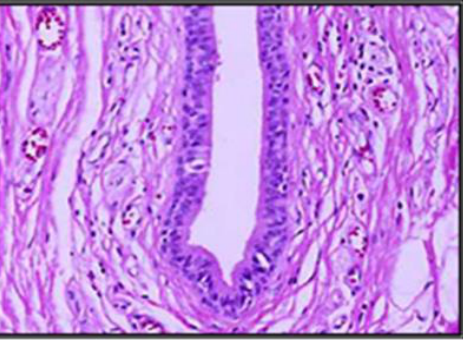
Figure 3. Concentration of bacteria type involved in periodontal pathology of study group.